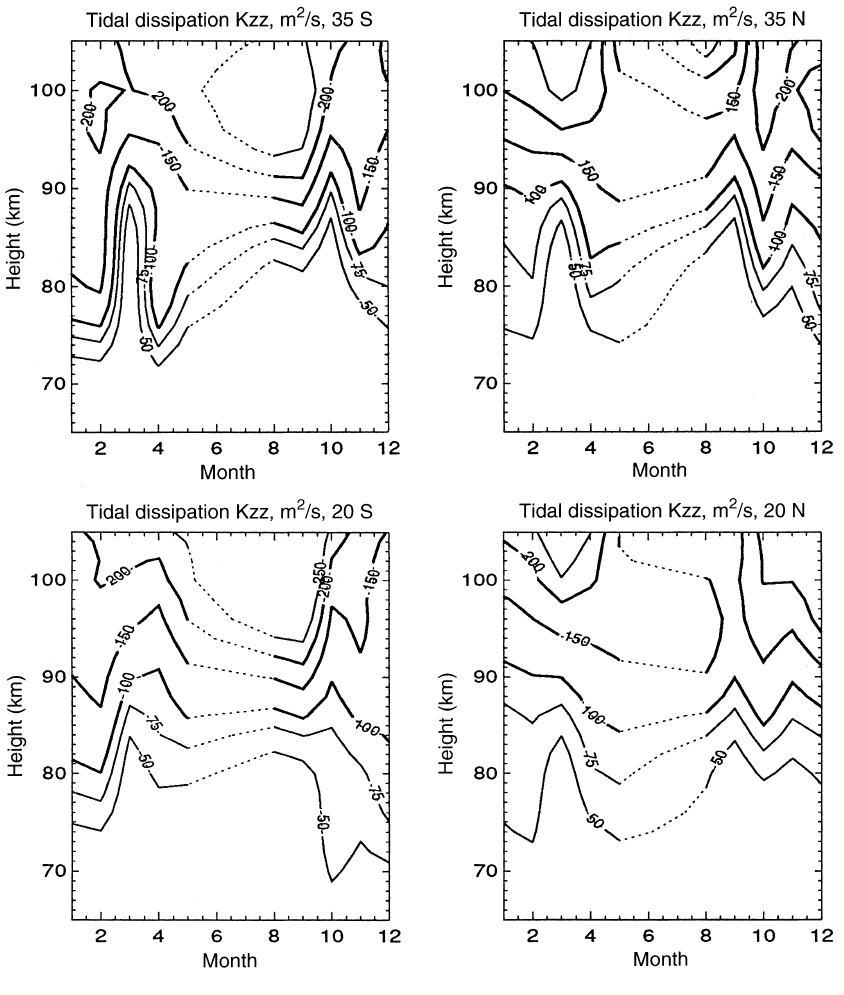
Fig. 10. Seasonal changes in the tidal dis- sipation from TMTM runs employing the 1992–1993 HRDI meridional wind for tun- ing. Latitudes roughly correspond to the locations of Adelaide (35 (cid:14) S), Kyoto (35 (cid:14) N), and Kauai (21